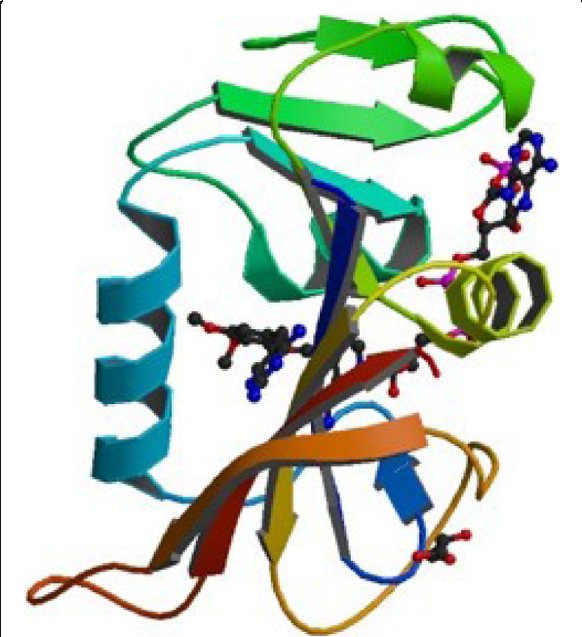
Fig. 2 Structure of the target protein dihydrofolate reductase (PDB ID: 2W9S)